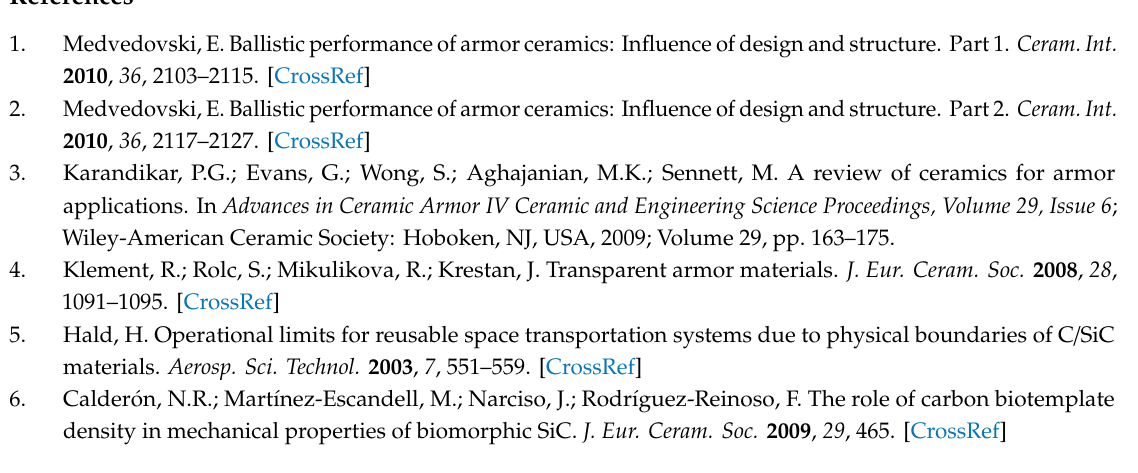
Figure 16. Fracture surface of the C f /SiC composite material after the 3-point bending test.